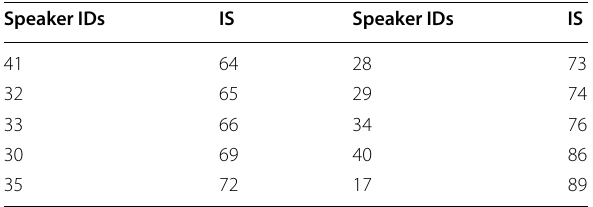
Table 3 Statistics of the Domotica